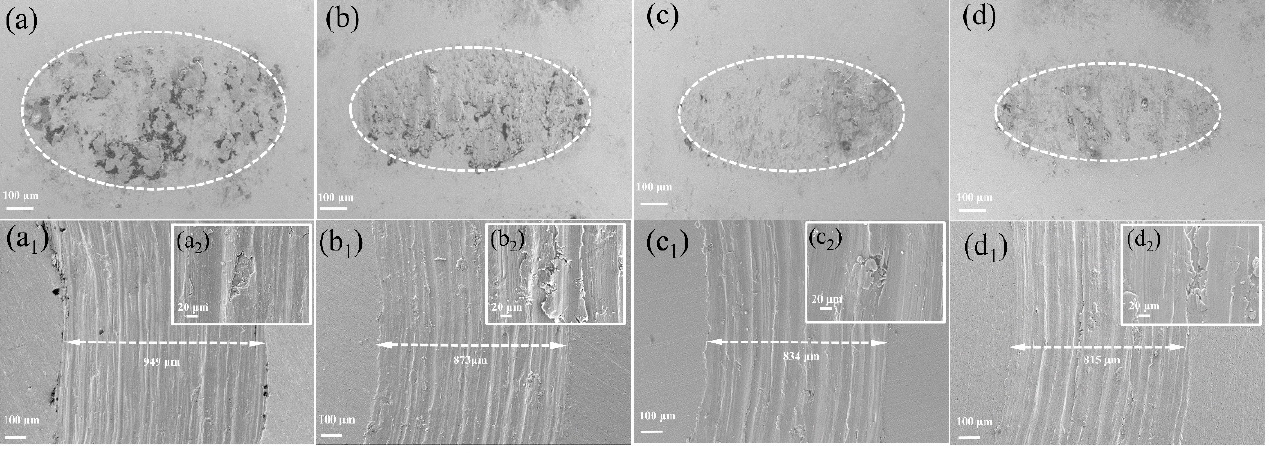
Figure 9. The EDS spectra of the worn surface of TI6AL4V discs lubricated by ( a ) Ultrapure Water, ( b ) L-BP, ( c ) M-BP, and ( d ) BPQD lubricant.